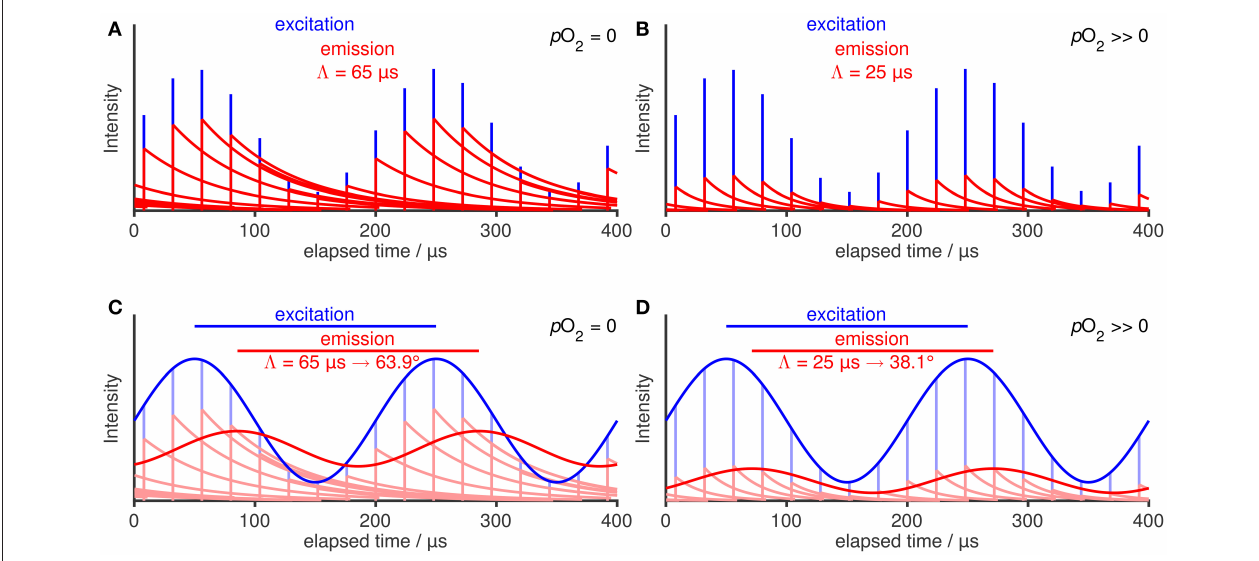
FIGURE 2 | Illustration of luminescence decay, quenching, and phase shift lifetime measurement under absence of O 2 (left column) and presence of O 2 (right column), respectively. Conceptual addition of many intensity-modulated excitation pulses (A,B) and superposition of the luminescence decays leads to an intensity-modulated and phase shifted emission in the continuous case (C,D) . The phase shift ϕ depends on the lifetime 3 according to Equation (4).